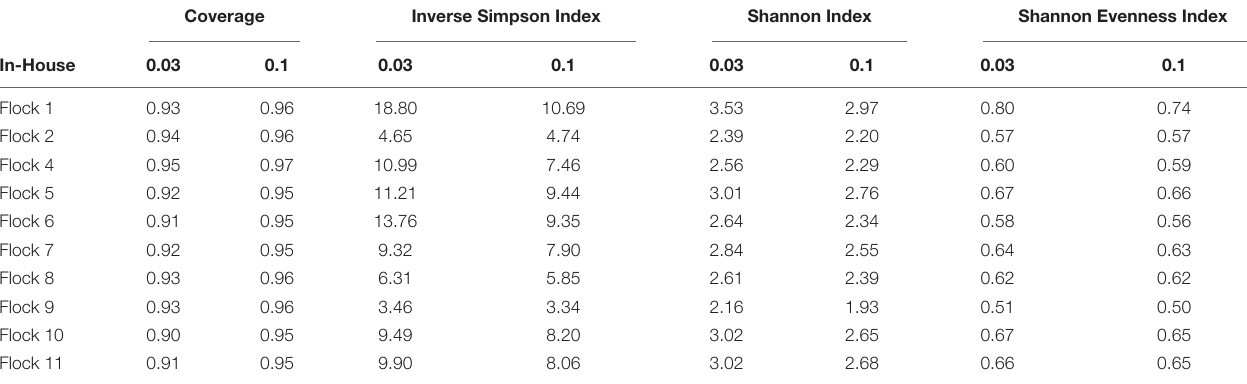
TABLE 1 | The coverage, diversity, and evenness indices at 0.03 and 0.10 genetic distances of bacteria from In-House A. diaperinus larvae associated with flock rotations. Coverage Inverse Simpson Index Shannon